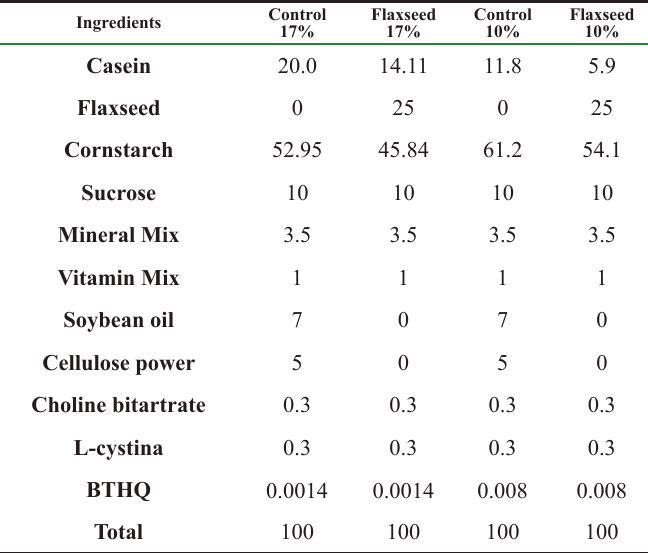
TABLE 1 – Composition of 100g of each experimental diet given during lactation (17% of protein: AIN-93G) and after the lactation period (10% of protein: